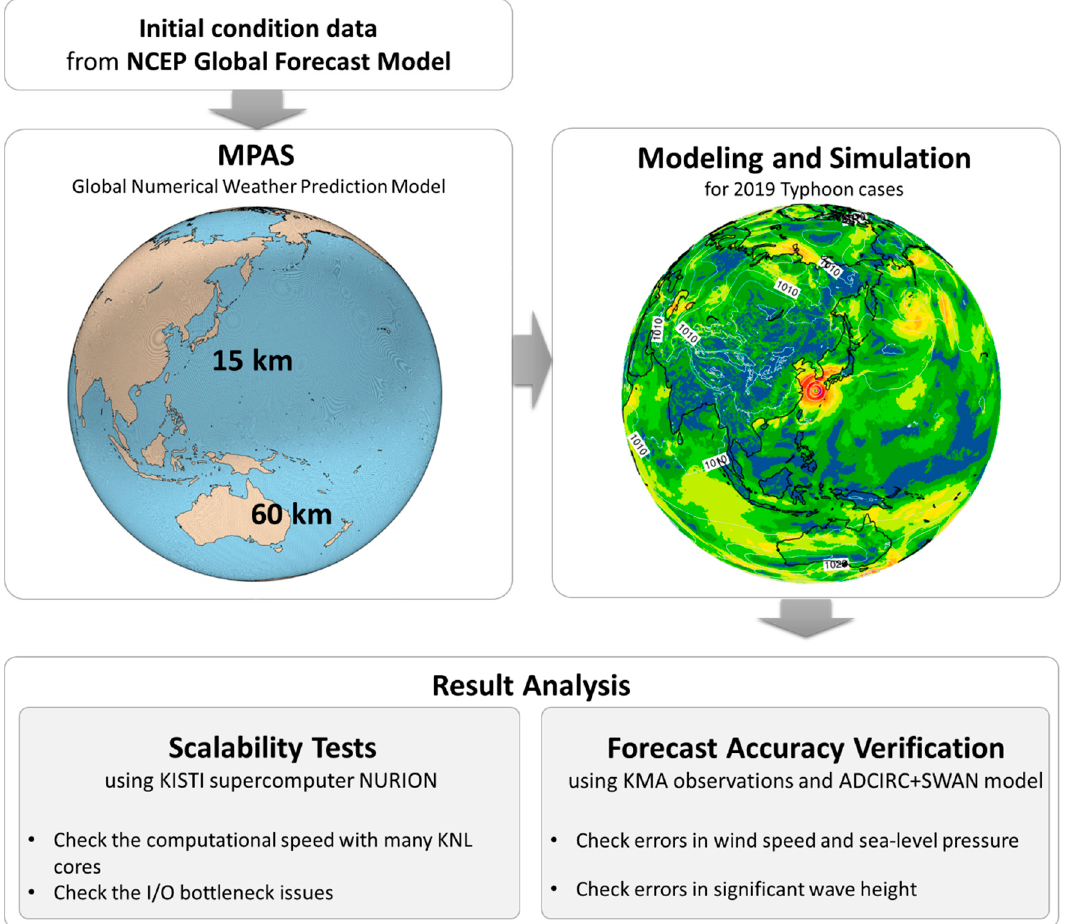
Figure 4. Flowchart showing the modeling and simulation and the analysis using the numerical models, the observation data, and the supercomputer.